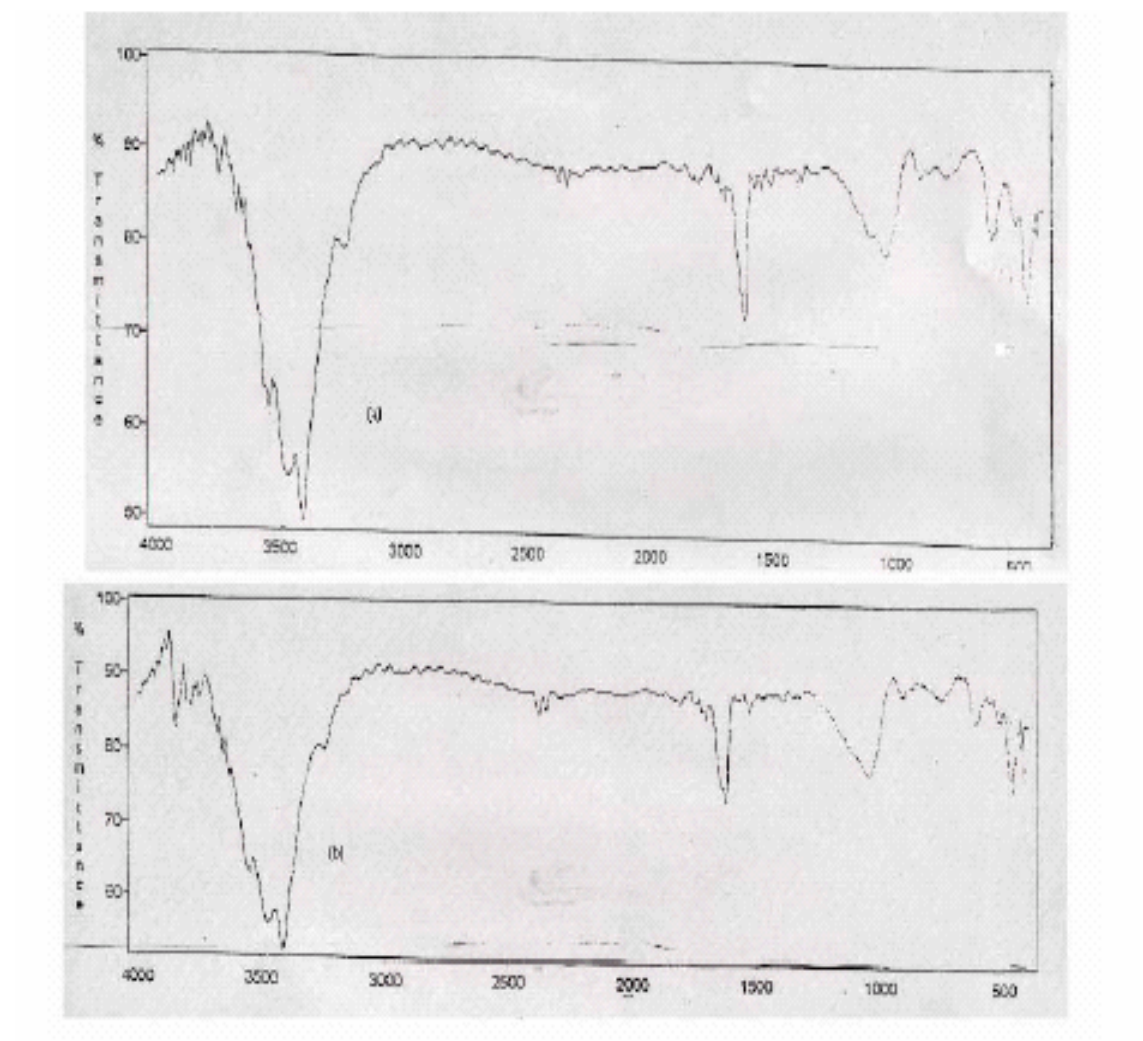
Figure 2. IR Spectra of (a) untreated Clay “Raw-Maghnite” and (b) Acid treated Clay “H-Maghnite0.25M”